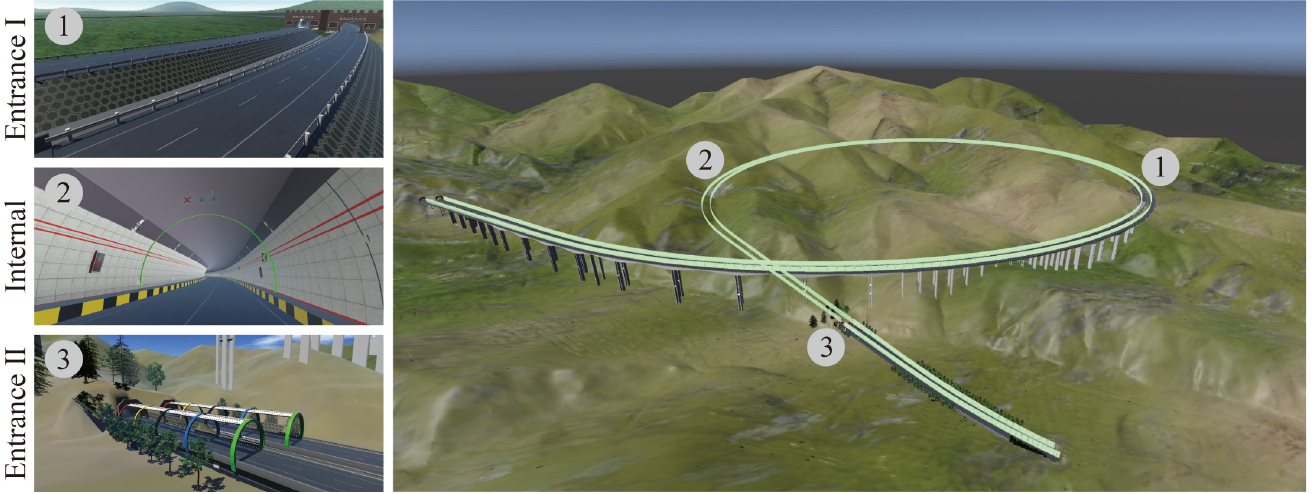
Fig 8. Several scenes of the DSC-BV-TI